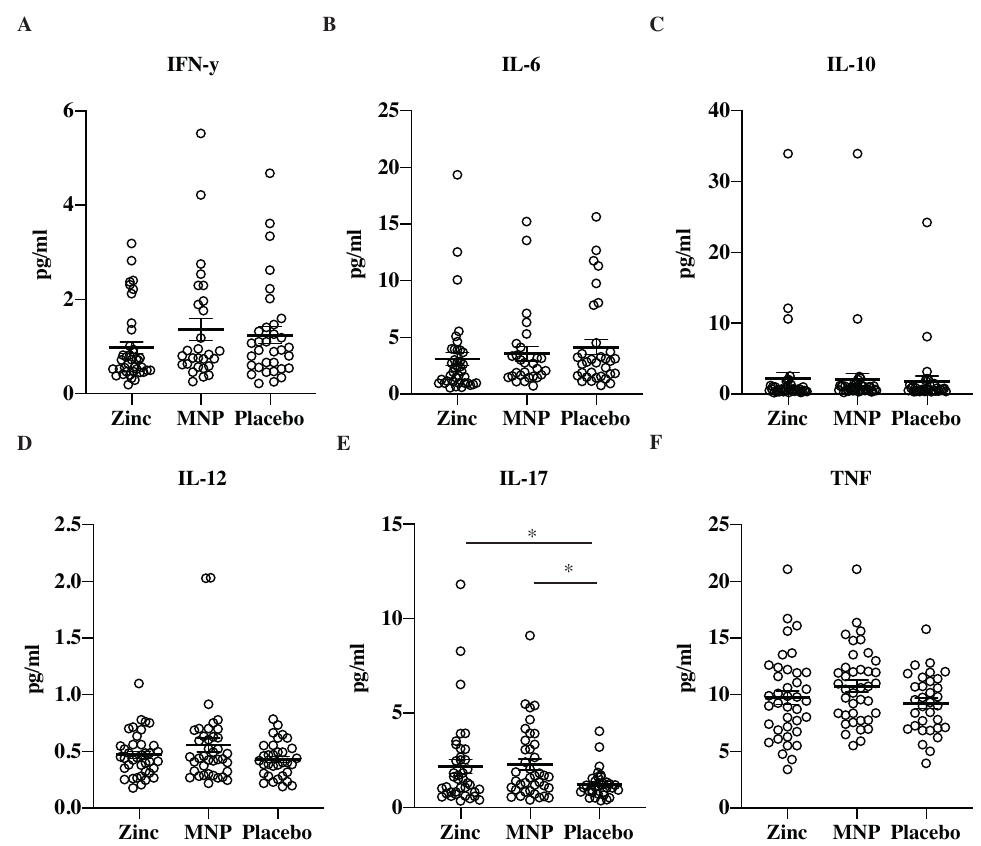
Figure 4. Analysis of serum cytokine levels after zinc tablet or multiple micronutrient powder (MNP) supplementation. Simoa multiplex analysis of serum samples taken from participants at